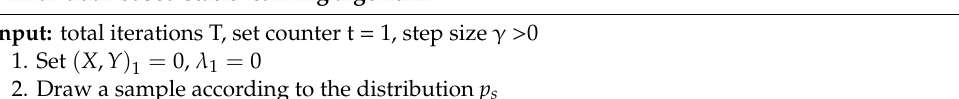
Table 2. The primal-dual learning algorithm. Primal-dual-based static learning